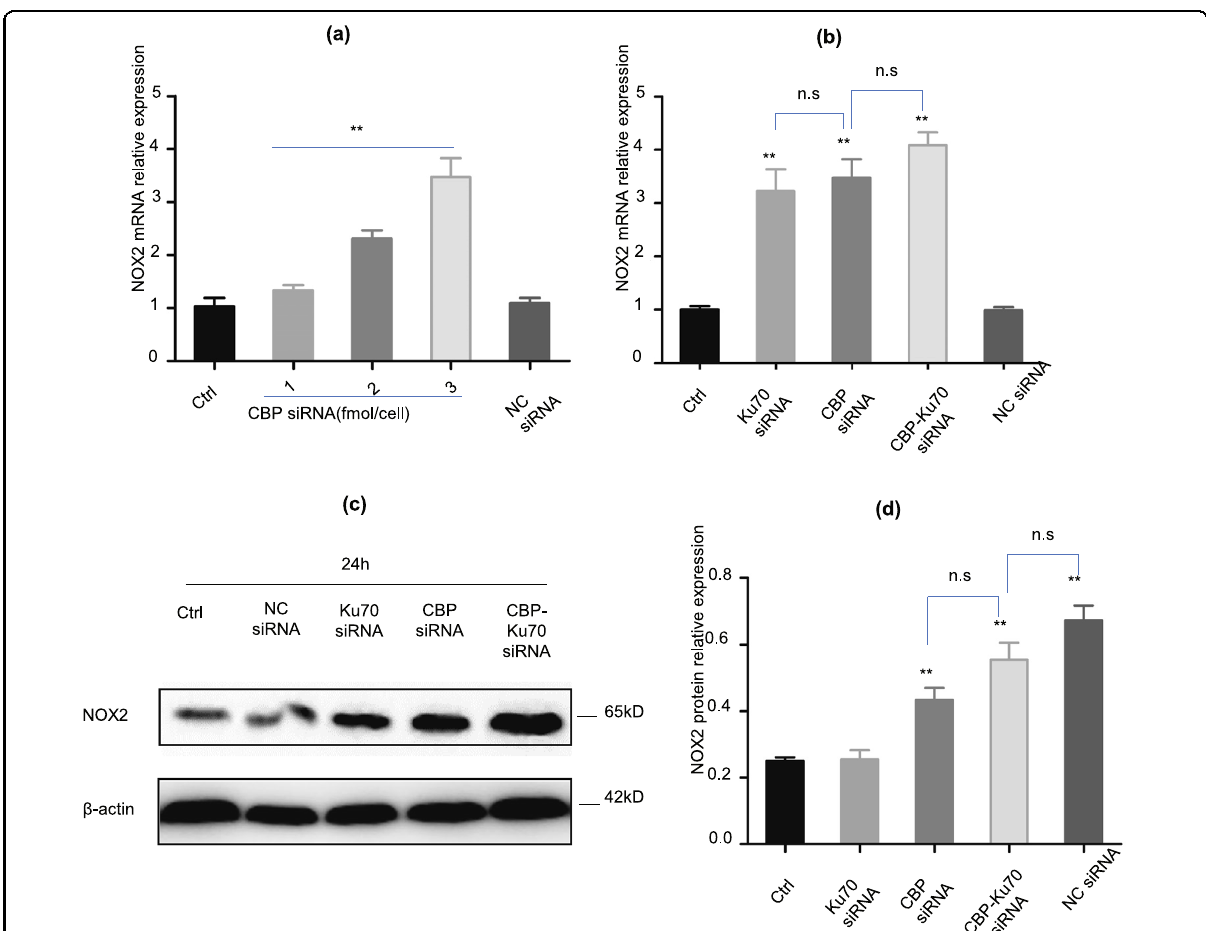
Fig. 4 Depletion of CBP and/or Ku70 enhanced the expression of NOX2. a The NOX2 mRNA level evaluated by RT-PCR; b the transcription of NOX2 when depleting Ku70, and simultaneously depleting both CBP and Ku70; c increased NOX2 protein in the cells depleting CBP and/or Ku70 measured by western blotting (the expression was compared to human β -actin as a gene for normalization); d The NOX2 protein level evaluated using western blotting, when depleting CBP or Ku70 individually or simultaneously. Data as shown in the fi gures were expressed as mean ± SEM ( n = 3). * P < 0.05, ** P < 0.01, # P < 0.05, ## P < 0.01, and n.s denotes P >